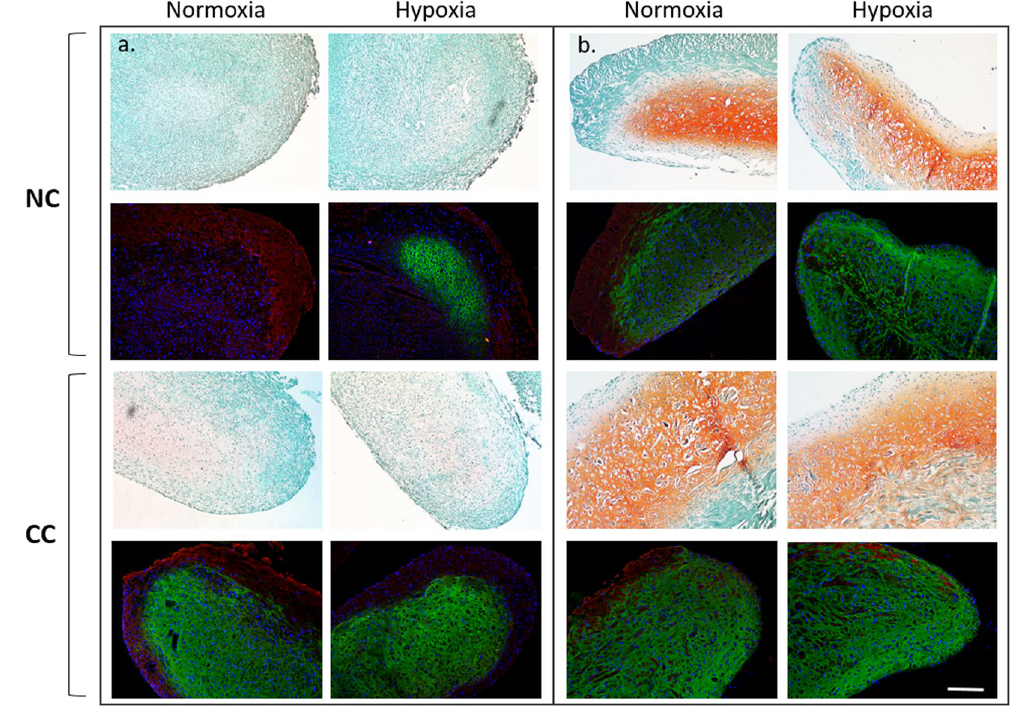
Figure 5. Effect of hypoxia and co-culture on tissue quality. ( a ). Top: Histological and immunofluorescence images for the worst donor (left, Bern Score = 1) in both normoxia and hypoxia. Bottom: Tissue generated with chondrocytes from the same donor co-cultured with BM-MSC in normoxia and hypoxia ( b ). Top: Histological and immunofluorescence images for the best donor (left, Bern Score = 8) Bottom: Tissue generated with chondrocytes from the same donor co-cultured with BM-MSCs. Fast green, Safranin O and haematoxylin staining showing the distribution of the collagen, GAG and cells respectively. Immunofluorescence images, red fluorescence is collagen I, green is collagen II and blue is DAPI for cell nuclei. Scale bar is 200 µ